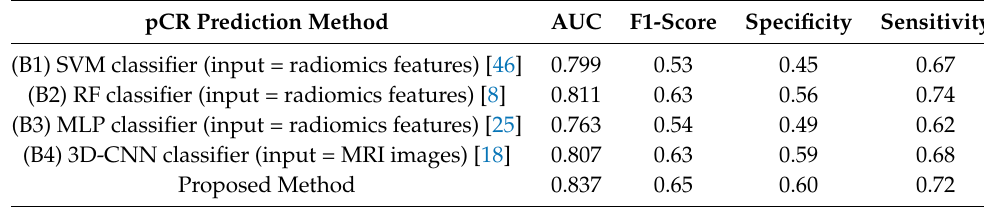
Table 5. Comparison of pCR prediction performance with competing